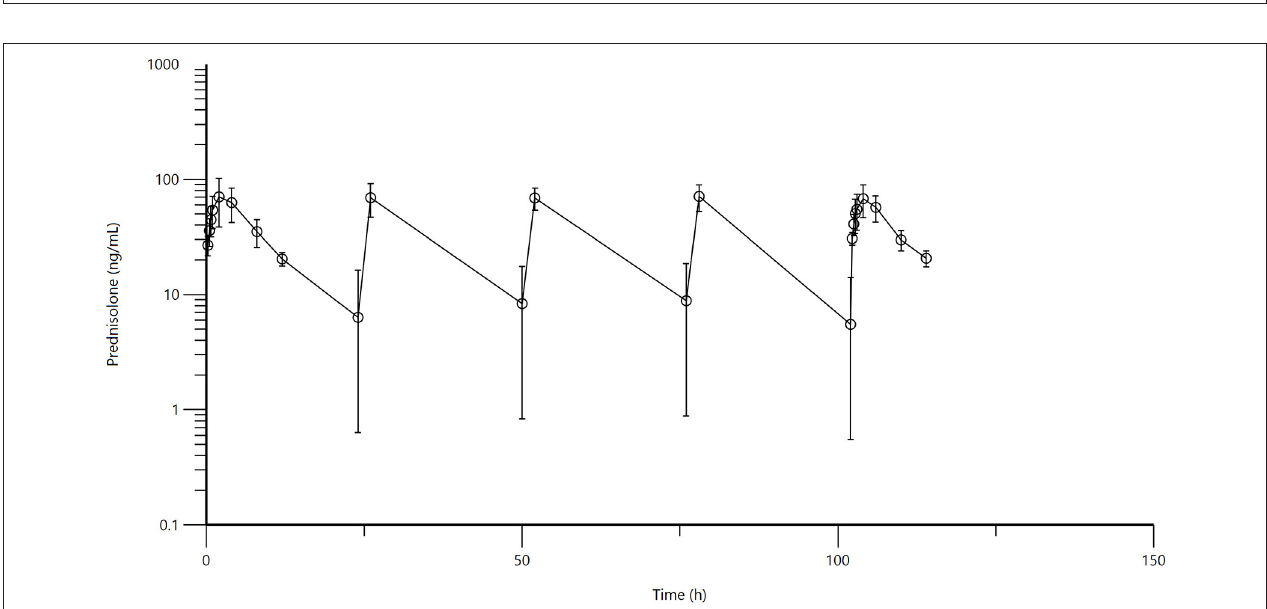
FIGURE 2 | Figure 1 : Mean plasma prednisolone concentration (logarithmic scale) vs. time (hr) profiles for adult alpacas ( n = 6) following oral (PO) muliple dose administration of 2.0 mg/kg of prednisolone. Mean is represented by an open circle with error bars representing standard deviation. Doses were administered at 0, 24, 48, 72, and 96